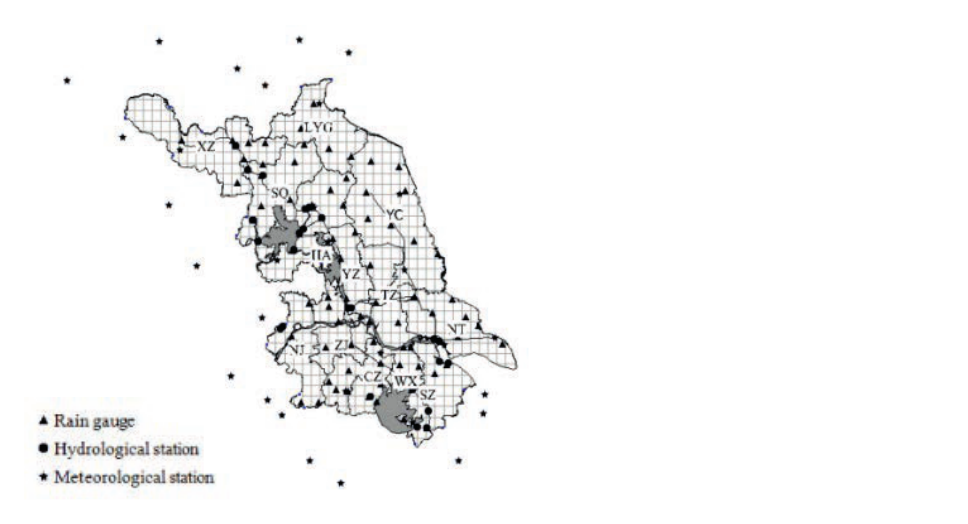
Fig. 1 Distribution of grids, meteorological stations and raingauge stations in Jiangsu